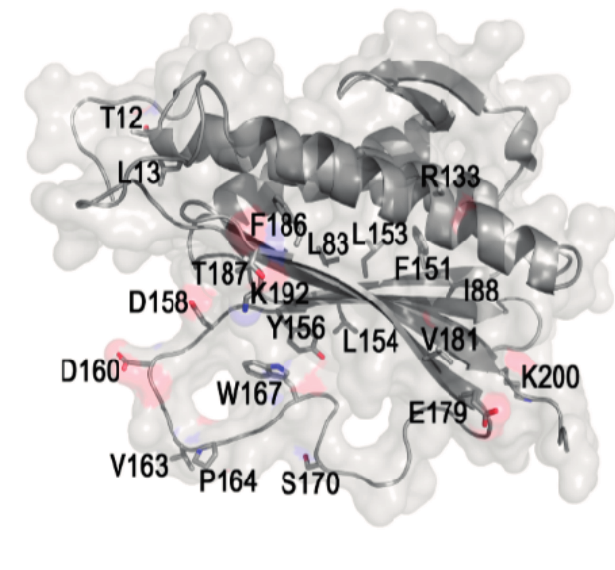
Figure 2. Variation of molecular descriptors for most relevant mutants. ( a ) Mad2 structure (Protein Data Bank code: 1S2H [17]) in ribbon representation, molecular surface colored light gray and mutants side chains represented as sticks. Only side chains of most relevant mutants are displayed, to illustrate their position within the structure; and ( b – d ) Deviation of molecular descriptors calculated as the difference between values for native protein and mutants: Van der Waals energy ( b ), protein hydrophobic moment ( c ) and protein hydrophobic ASA ( d ). Order of mutants (thus also mutants labelling) is the same in all